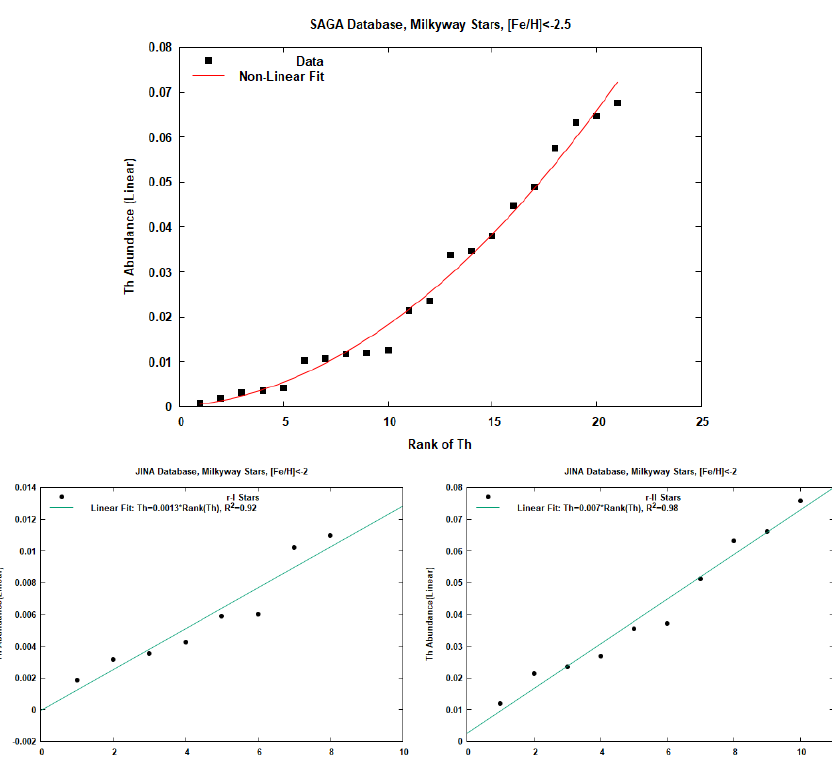
Figure 4. Top: Th abundances vs. their rank for low-metallicity stars, i.e. r-enriched r-I and r-II stars. Bottom left and right: The same but considering r-I and r-II stars separately. The linear relationship points to a single nucleosynthesis source for each of these two